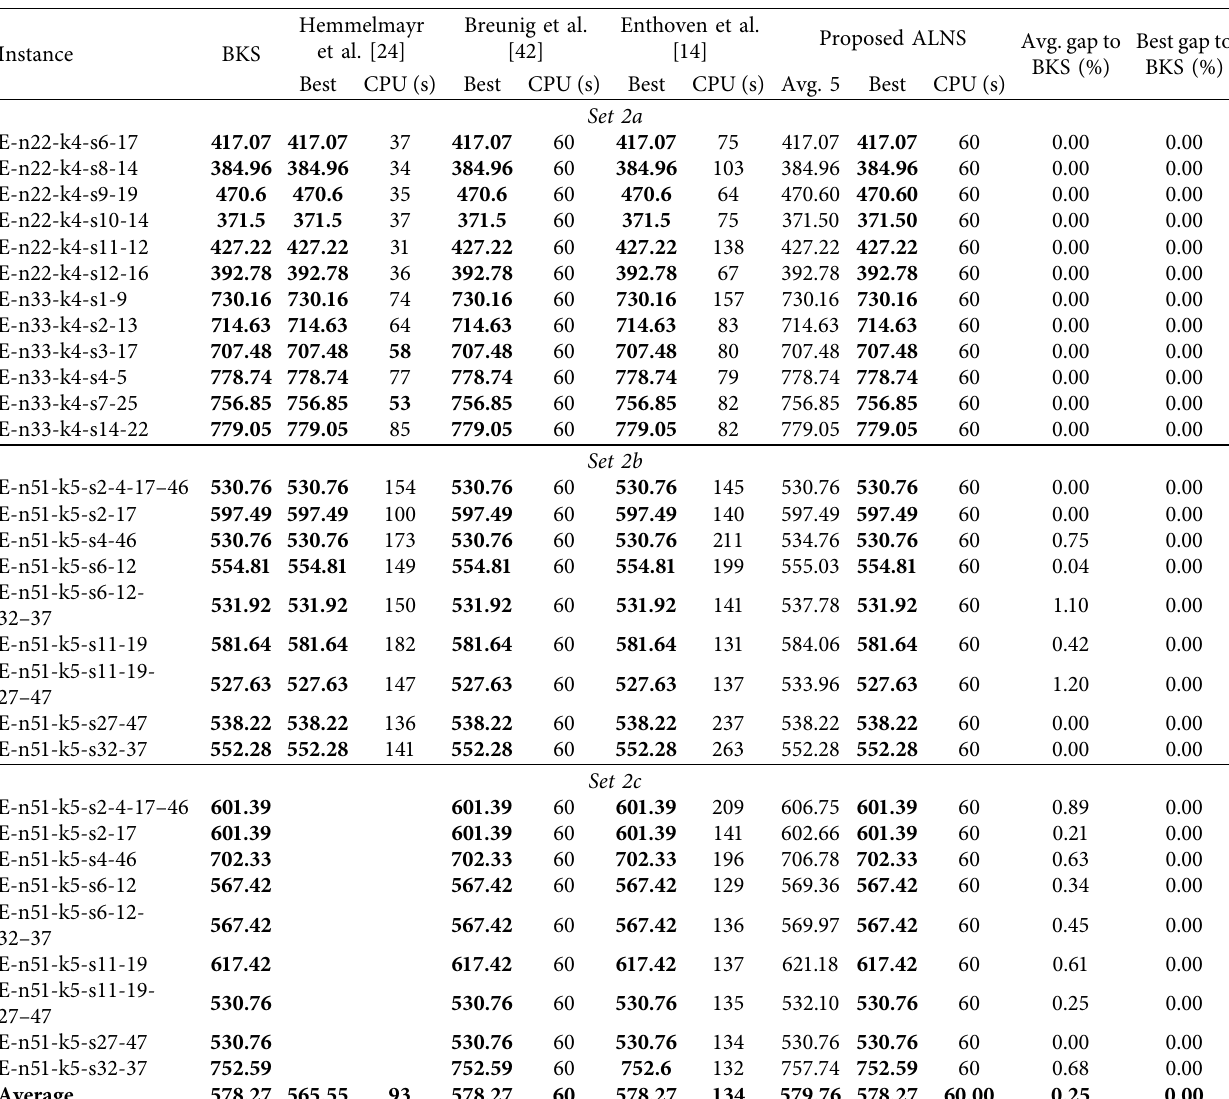
Table 3: Comparative results for solving 2EVRP Set 2